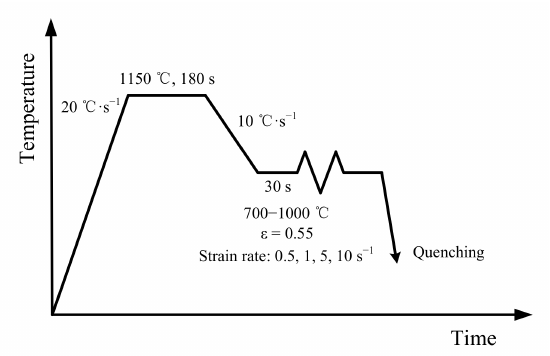
Figure 1. Hot-deformation